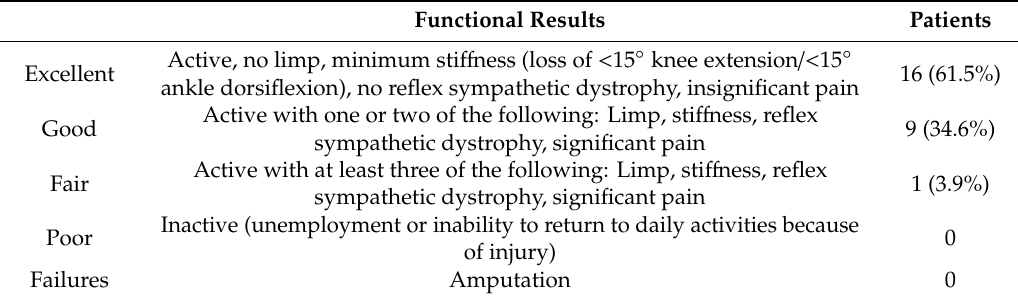
Table 2. Functional results according to ASAMI Scoring System.